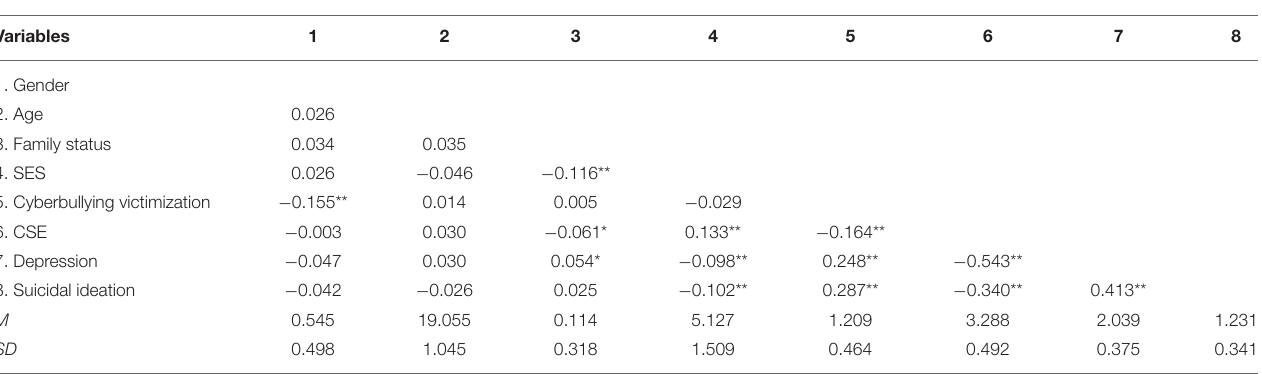
TABLE 1 | Descriptive statistics and intercorrelations between